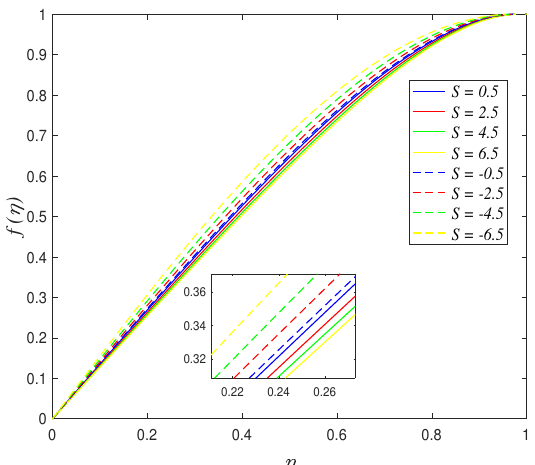
Figure 2. Impact of S on radial